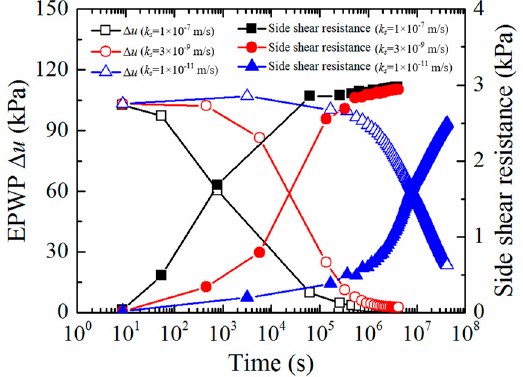
Figure 22. Comparisons between the dissipation of EPWP and pile set-up at depth of 7.5 m under various soil permeability coefficients after pile installation.